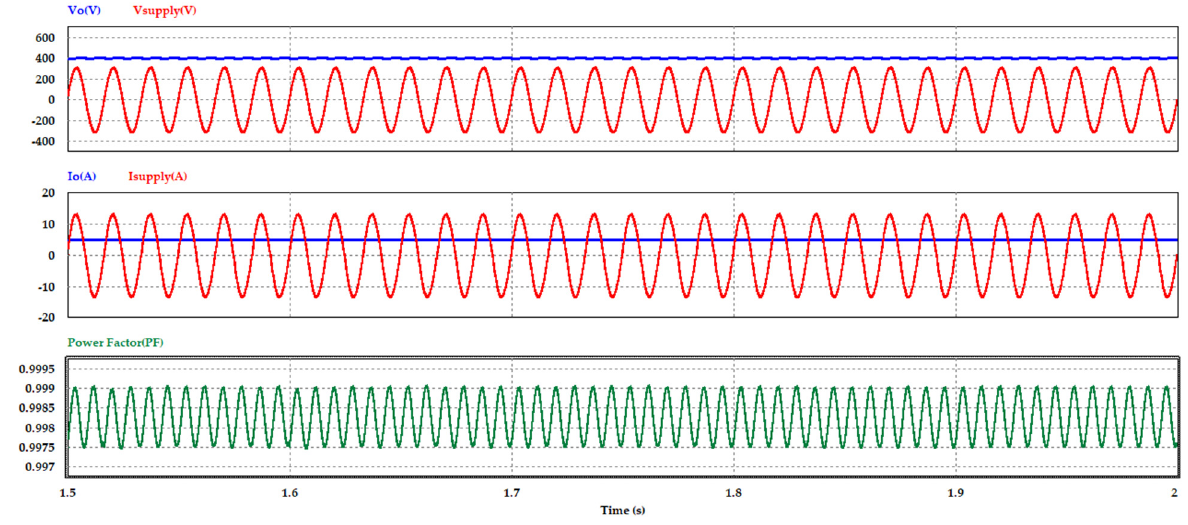
Figure 14. Voltages, currents, and input power factor for the conventional CCM PFC at full load condition.